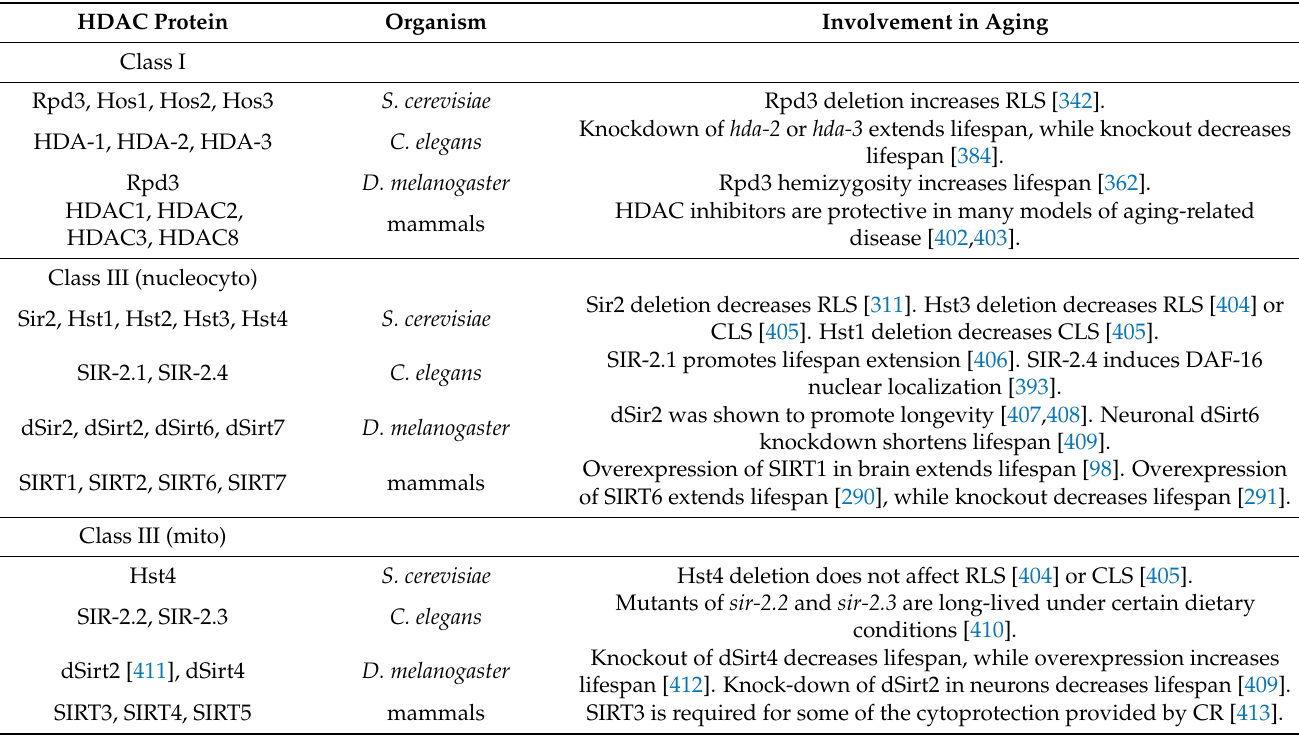
Table 2. Class I and III HDACs and their involvement in aging in model organisms. HDAC Protein Organism Involvement in